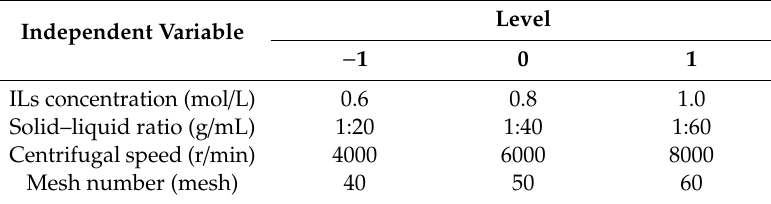
Table 1. Box–Behnken design (BBD) for the independent variables and corresponding response values. ILs, ionic liquids.